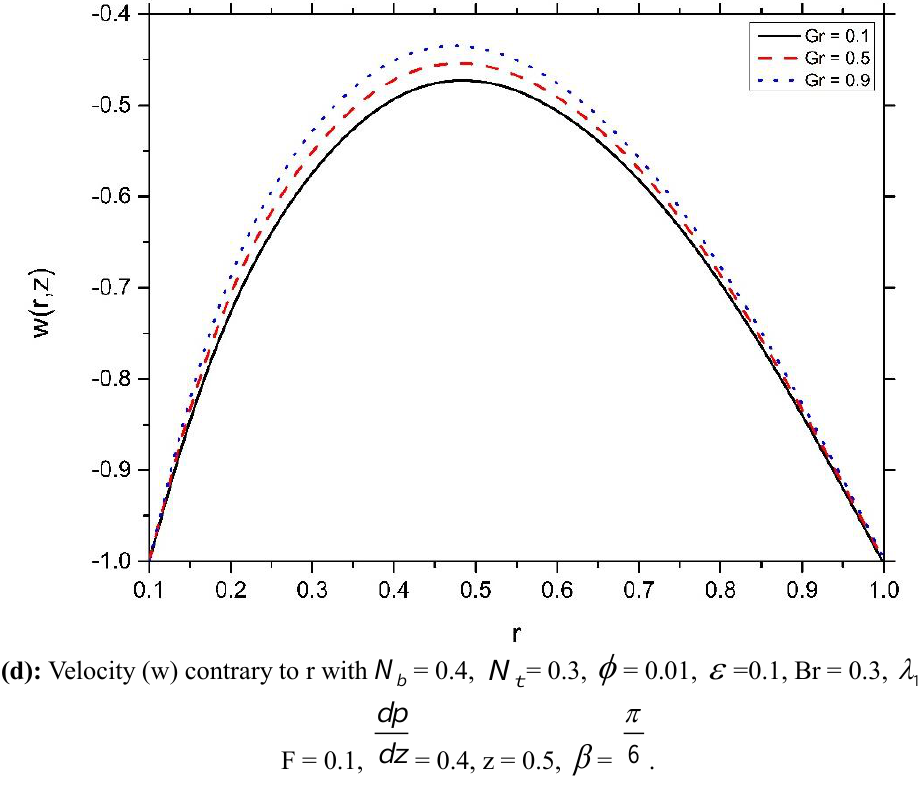
Fig. 3(d): Velocity (w) contrary to r with